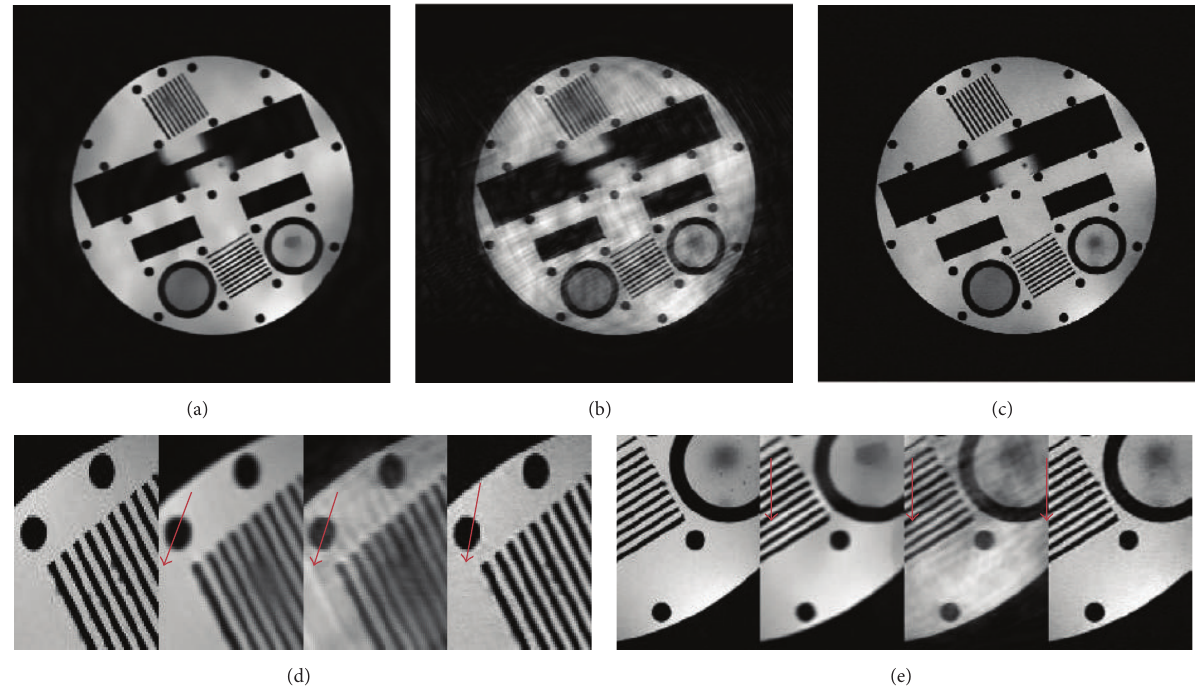
Figure 6: Comparison of reconstruction of a physical MR image with noise of 𝜎 = 30 . ((a), (b), (c)) Reconstruction results of DLMRI, SHTGV, and DLTGV at 8-fold undersampling. ((d), (e)) The area of enlargements corresponding to (a), (b), and (c).